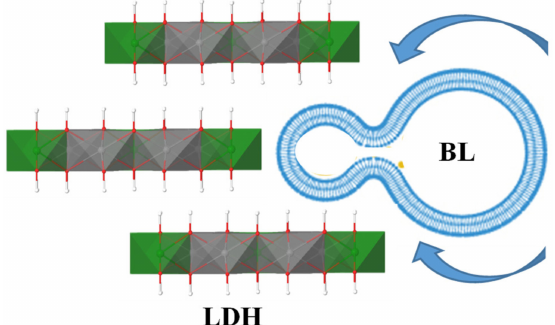
Figure 7. Three di ff erent 27 Al environments (A, B and C) were detected and confirmed by means